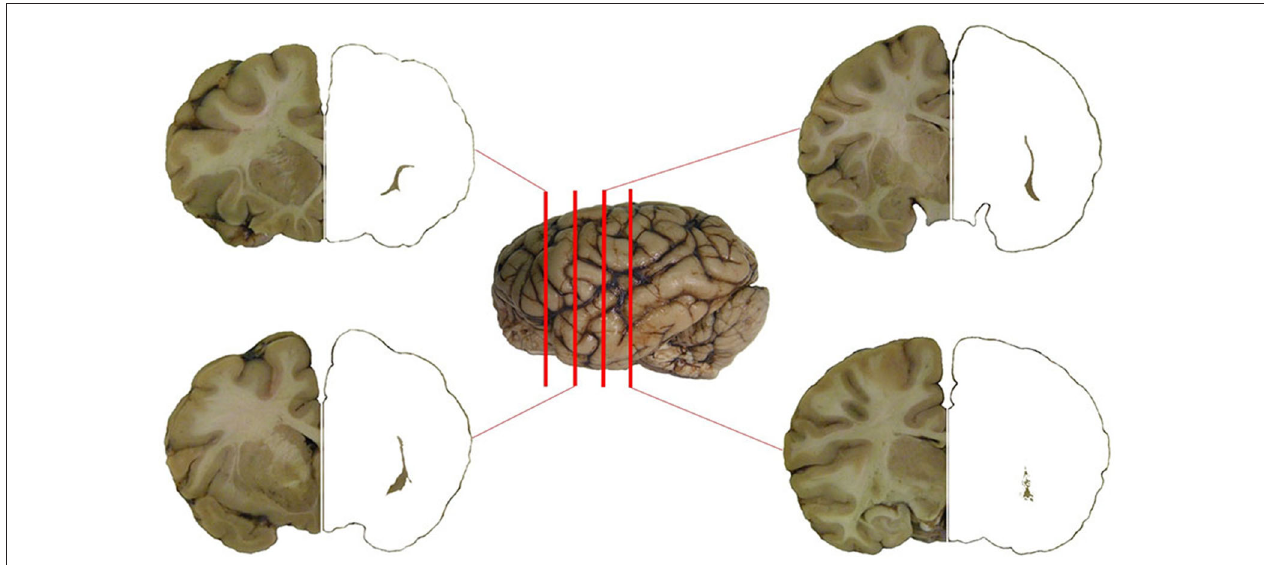
FIGURE 1 | The claustrum of the chimpanzee in four subsequent sections of the brain . Position of the section is represented against the left side of the brain. The claustrum has been isolated on the right side of the four sections.